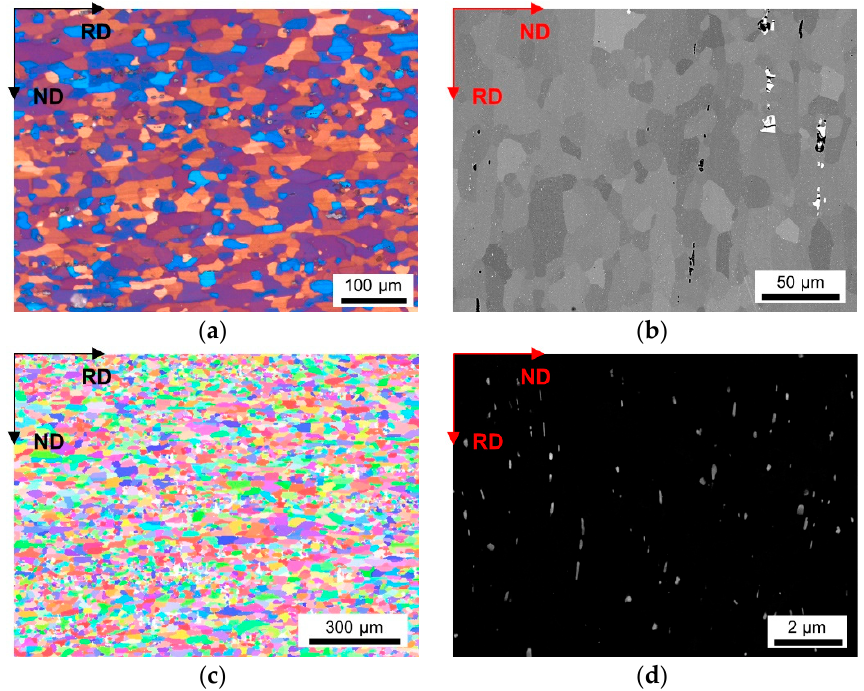
Figure A8. Microstructure of the soft annealed LFe-HMn cast under S-C condition, homogenized at 500 °C and cold rolled to a CRD of 35%. ( a ) LOM. ( b ) BSE image. ( c ) EBSD IPF map in RD–ND plane. ( d ) BSE micrograph showing dispersoids.